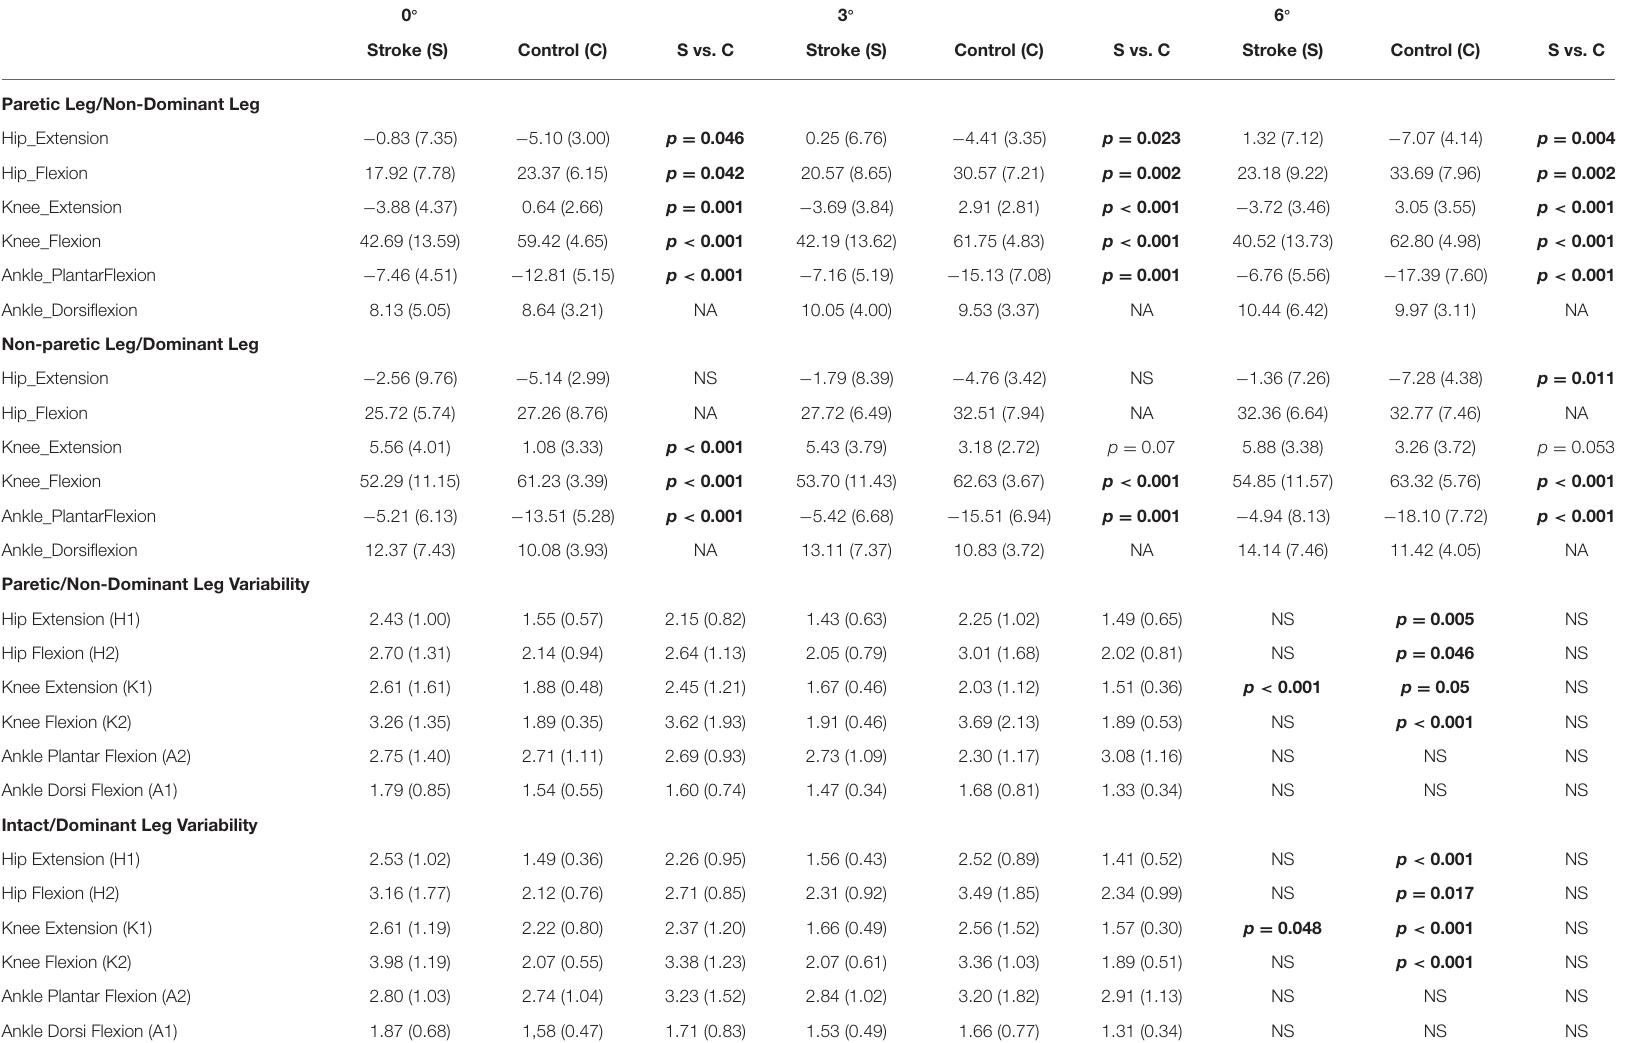
TABLE 2 | Values of the joint angle and joint angle variability in the paretic/non-dominant leg and non-paretic leg/dominant leg in the stroke survivors and controls. 0 ◦ 3 ◦ 6 ◦ Stroke (S) Control (C) S vs. C S vs. C Stroke (S) Control (C) S vs.